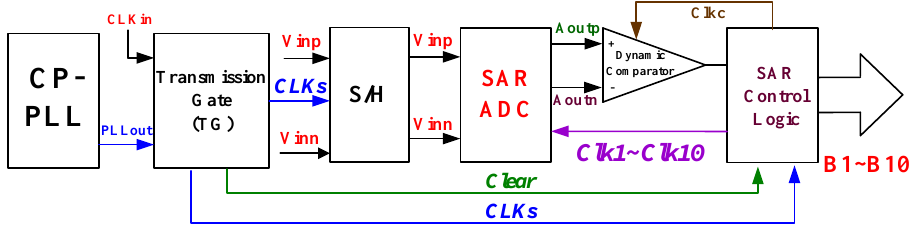
Figure 2. System block diagram of the proposed PLL-SAR ADC with a bootstrapped switch.